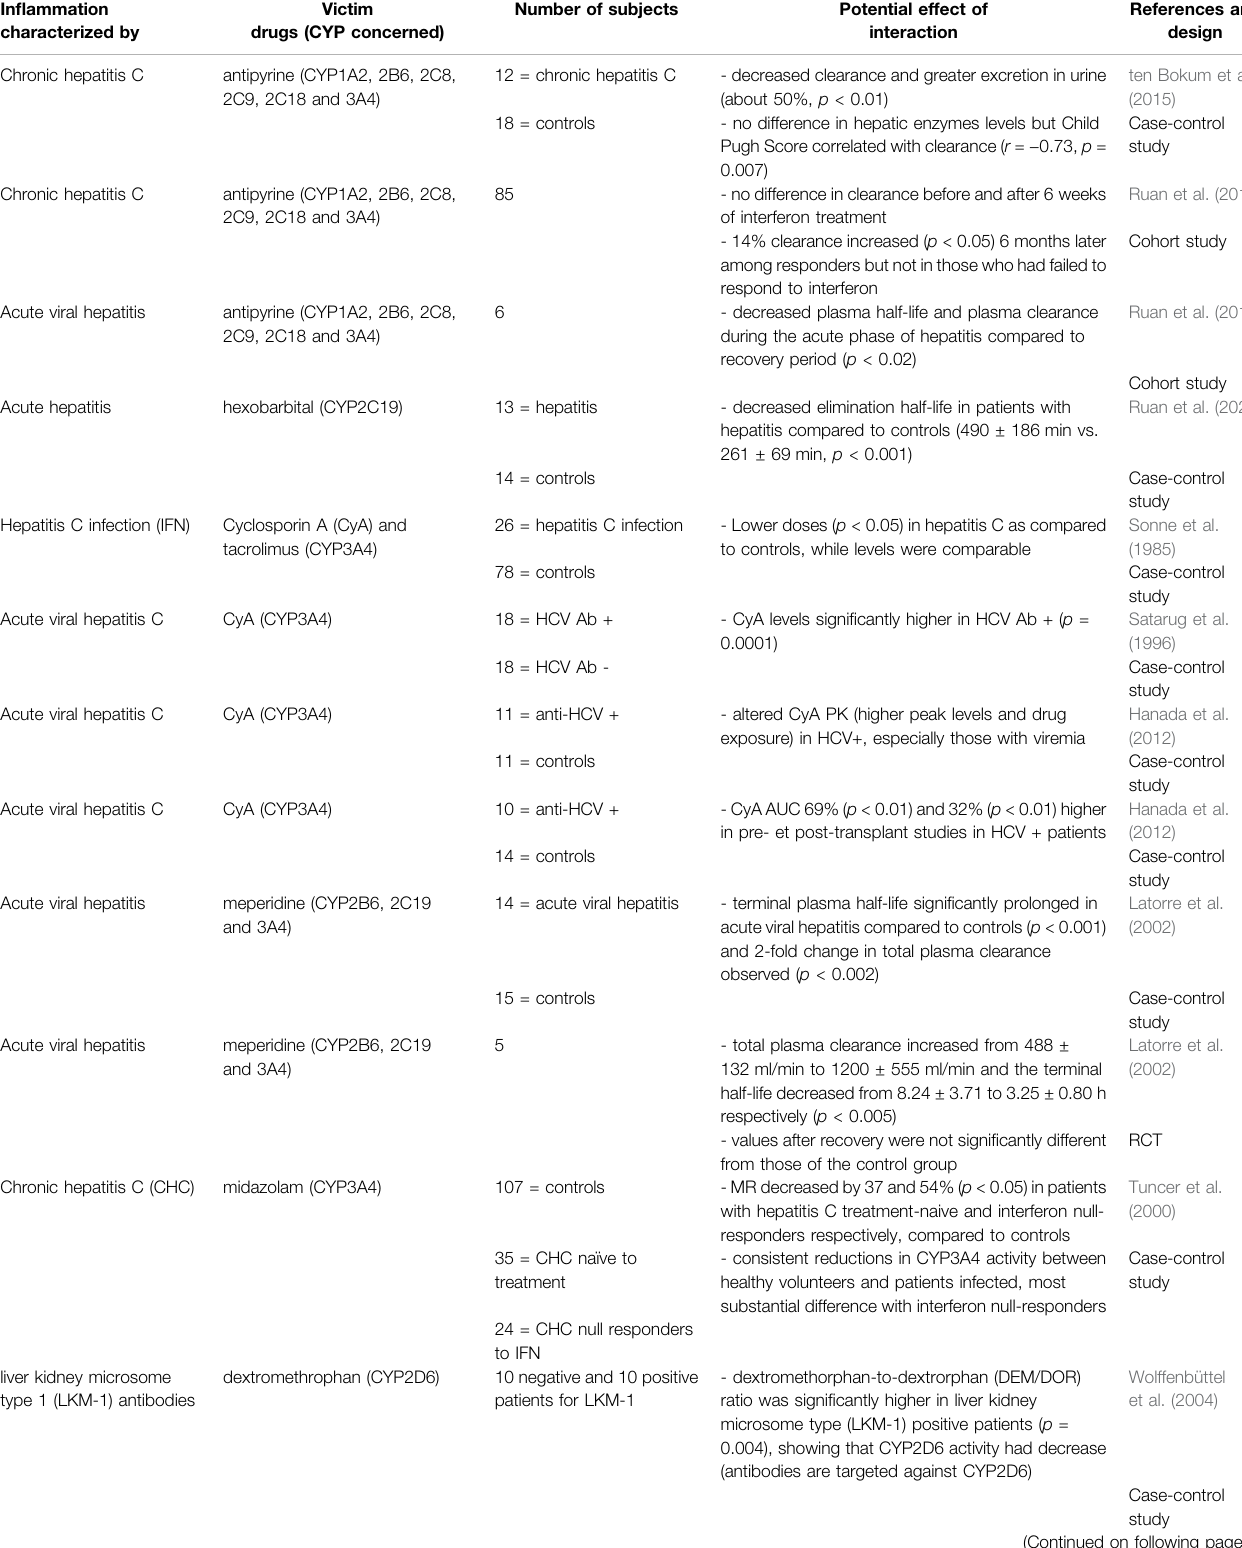
TABLE 2B | Impact of hepatitis on CYP substrates, explained totally or partially by modulation of CYP activity. In fl ammation characterized